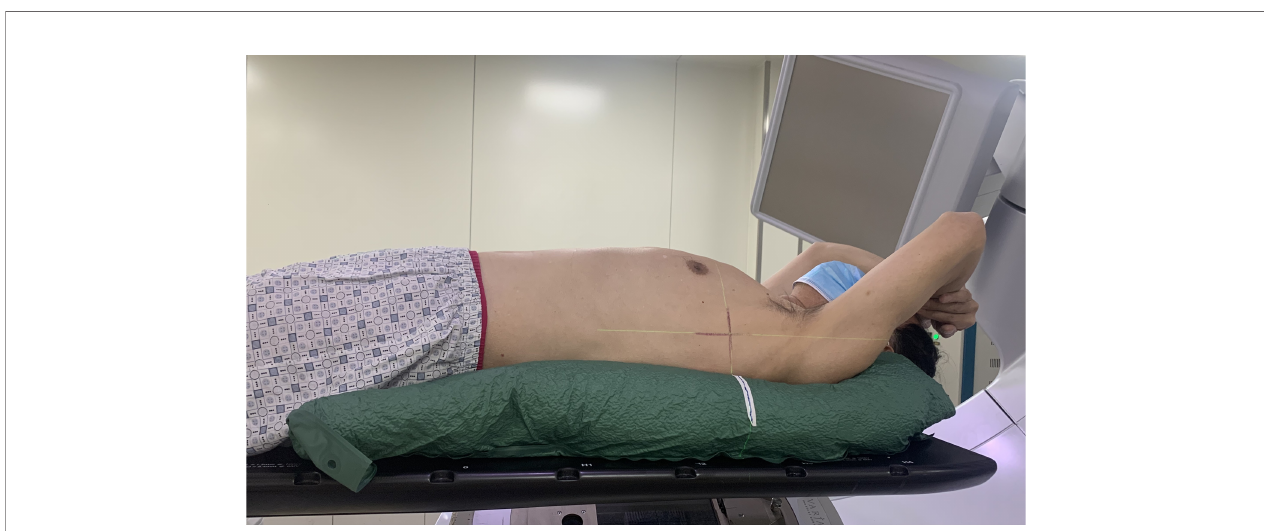
FIGURE 1 | Example of immobilization and localization systems with vacuum cushion. Patient is in the supine position and immobilized by a vacuum cushion with the arm placed above the head during free breathing. The marker on vacuum cushion and the skin marker on the patient are both aligned with the room